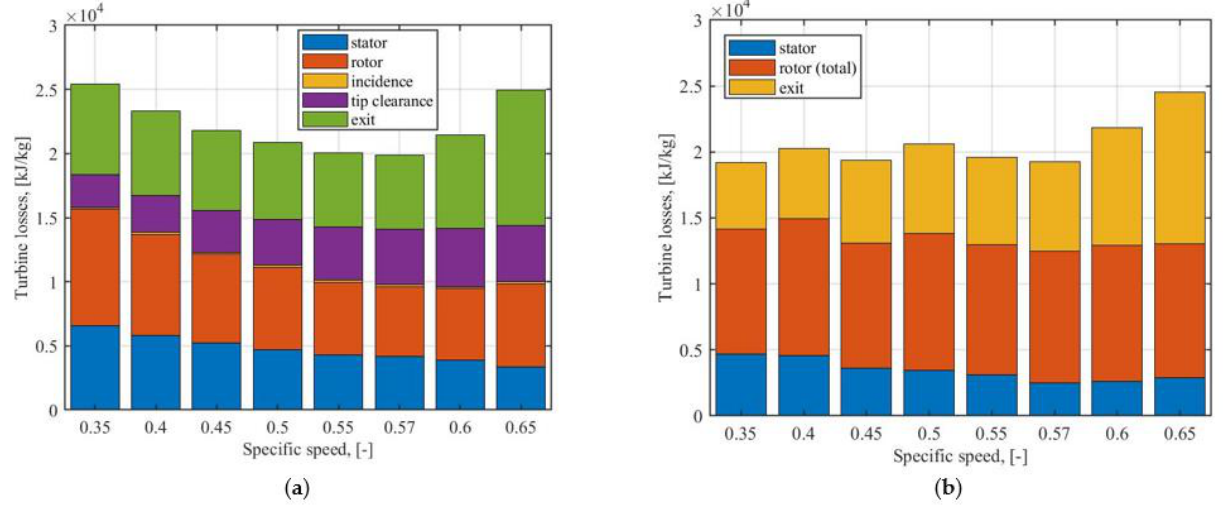
Figure 10. The turbine loss distributions ( a ) obtained with the loss models (PLM3) and ( b ) the CFD results for the losses.